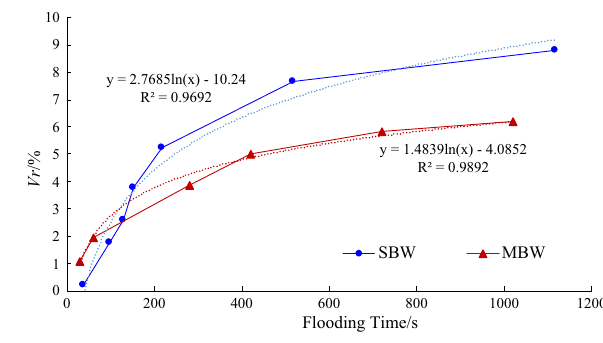
Fig. 10 Pressure at the fluid inlet side corresponding to the single- branch sand production patterns in trapezoidal models